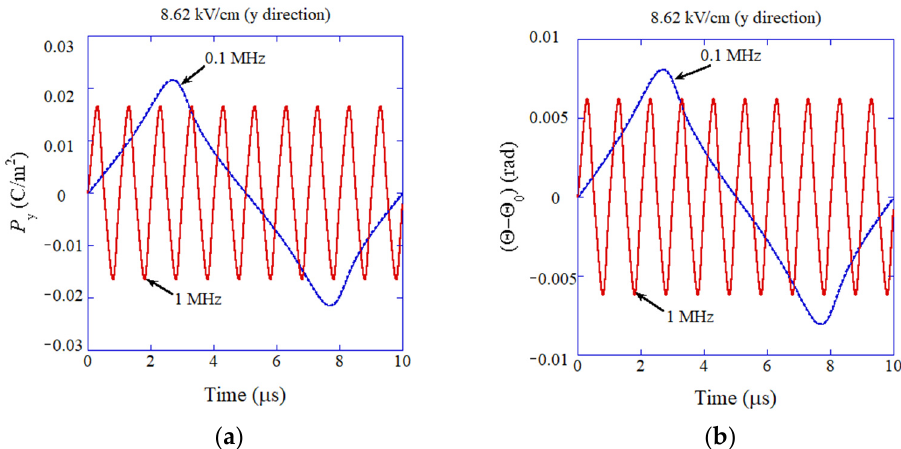
Figure 10. The results of numerical simulation of the ODE model for dynamic response of flexoelectric polarization of BaTiO 3 nanocubes ( a ) The component of polarization parallel to the applied electric field (y-direction). ( b ) The angle ( Θ ) of polarization. Reprinted with permission from Ref. [87]. Copyright 2022, MDPI.